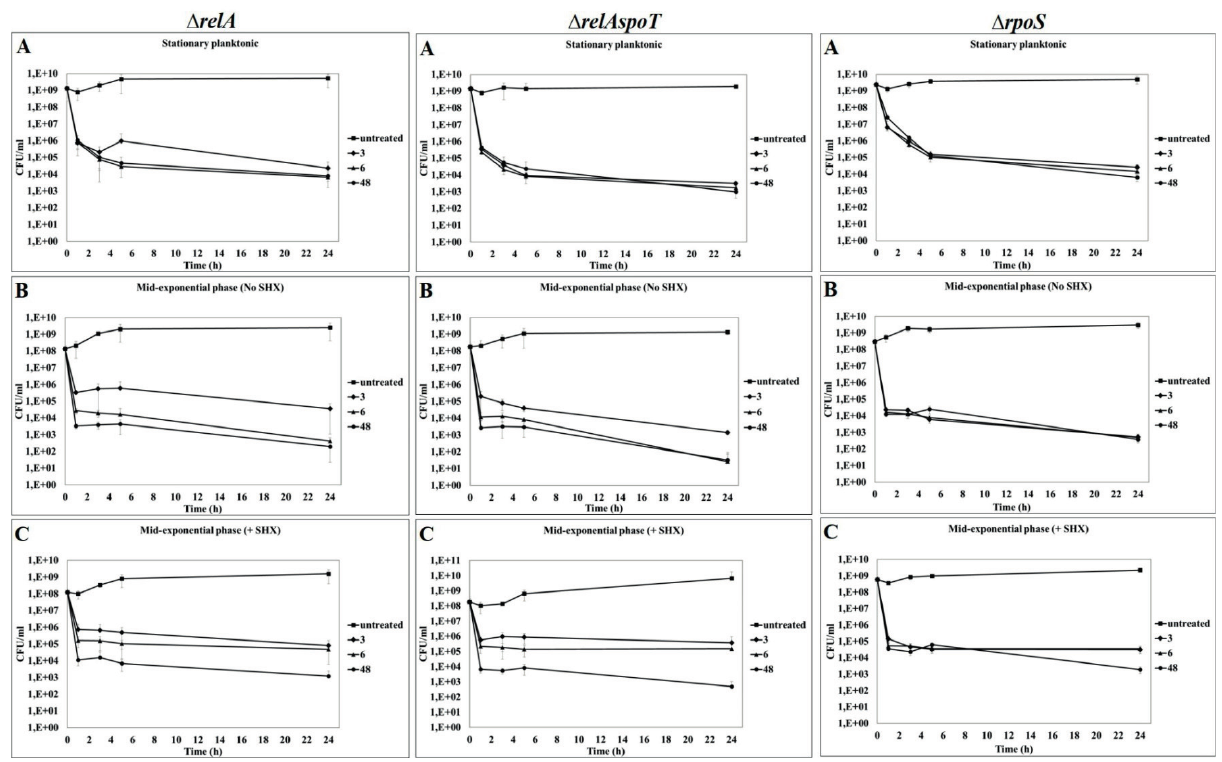
Fig. 6. Killing of P. aeruginosa PAO1 relA , relAspoT and rpoS mutants by ciprofloxacin. Cultures were exposed to 6 μg/mL of ciprofloxacin for 1, 3, 5 and 24 h and then plated for colony forming units (CFU/mL). The percent survival is not shown. The values are averages of three independent experimetns and error bars are not shown, and the error bars indicate the standard error of the